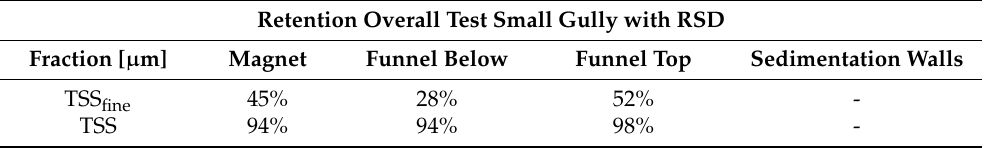
Table 8. Results for the retention rate for tests at the small test stand.